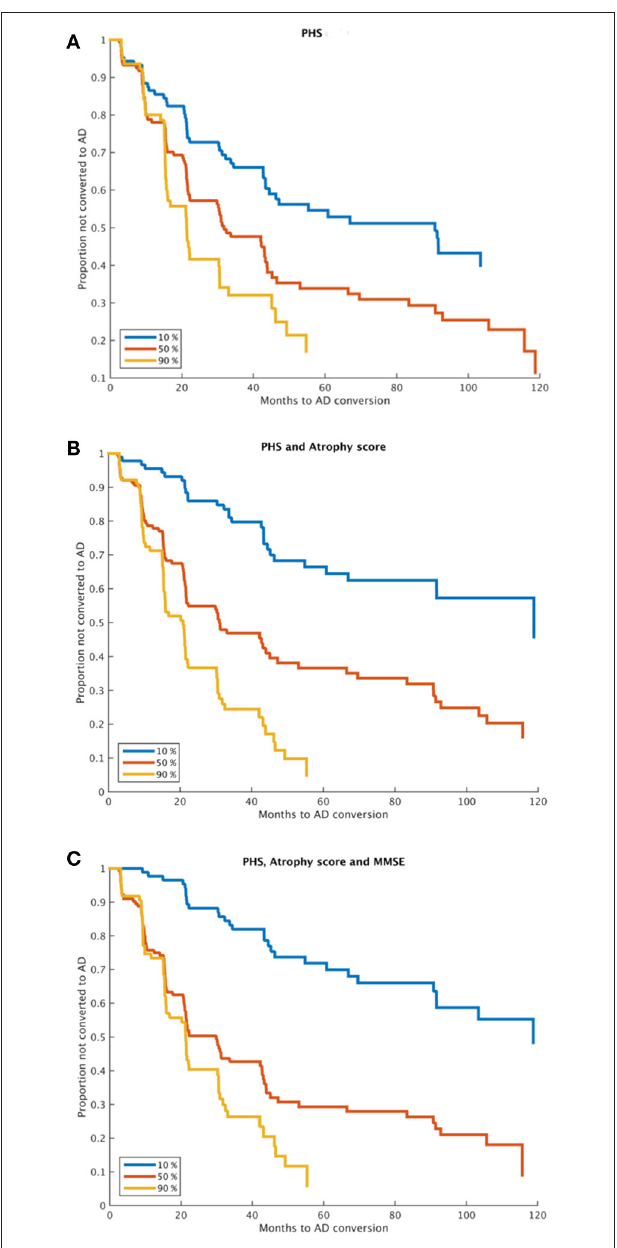
FIGURE 1 | Time to MCI to AD progression. Kaplan-Meier survival curves for 10, 50, and 90th percentiles of (A) PHS, (B) PHS and atrophy score, and (C) PHS, atrophy score and MMSE (at baseline). Model comparisons using log likelihood of the two-factor model (B) vs. any one-factor model, and the three-factor model (C) vs. any combination of two-factor models; all p < 0.005. PHS, Polygenic Hazard Score; AD, Alzheimer’s Disease.